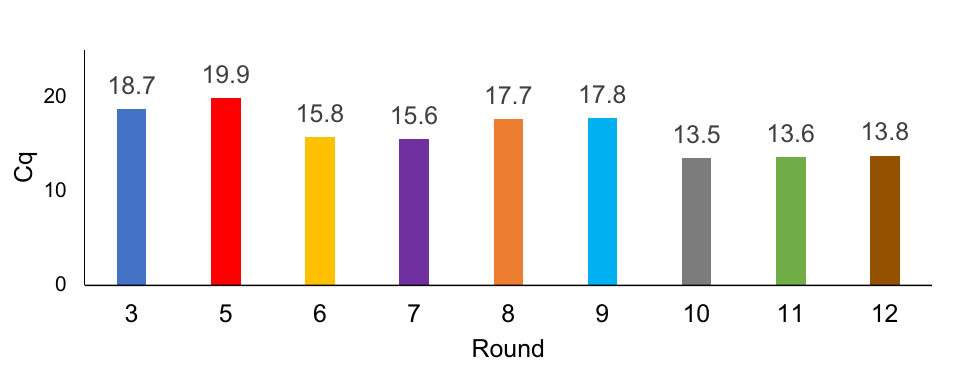
Figure 1. Schematic diagram of SELEX method for selection of MLL-AF9 RAS-specific DNA aptamers with internal counter selection method.